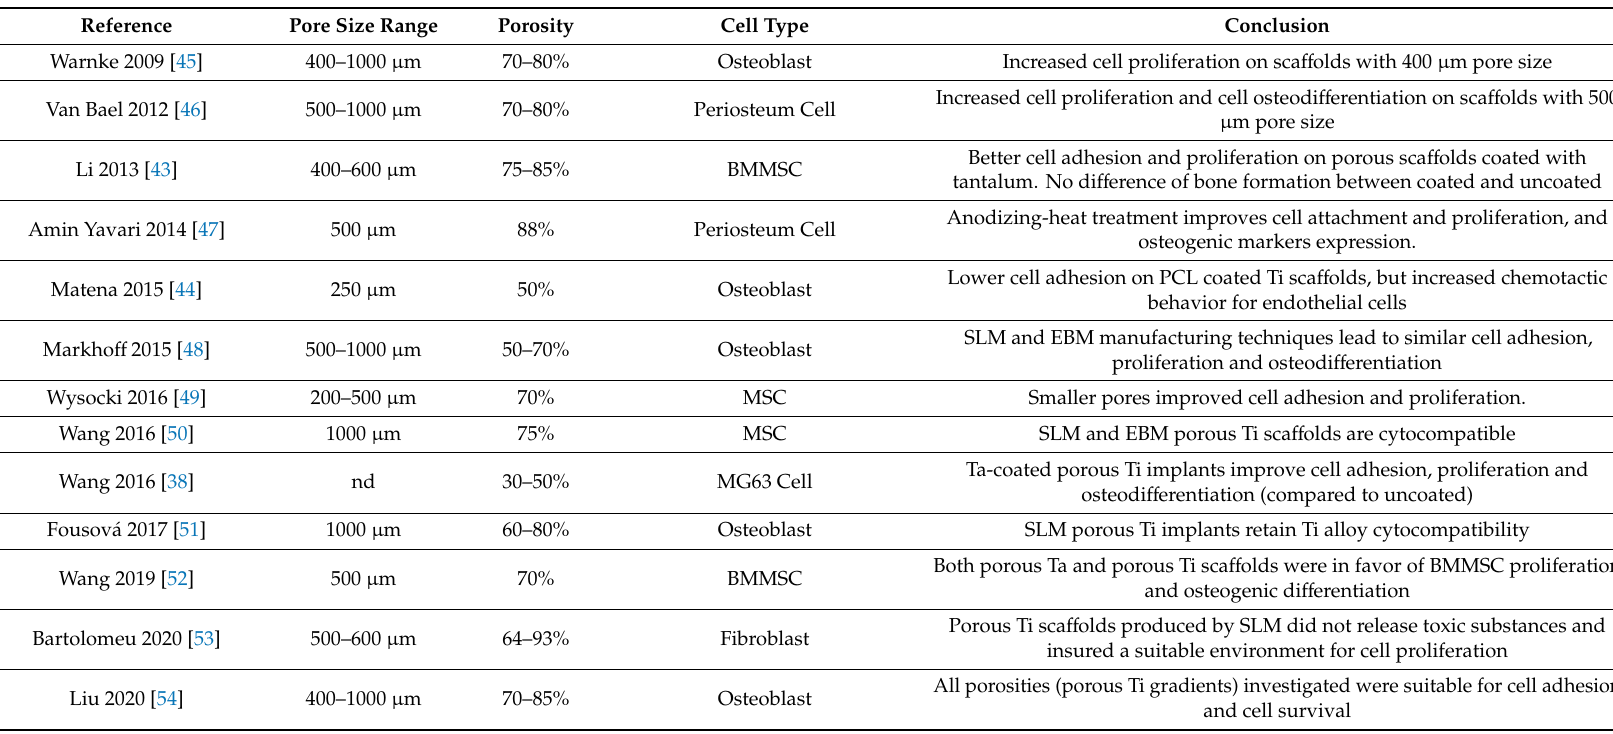
Table 3. Main results from previously published after in vitro studies on porous titanium sca ff olds, with comparable pore size and / or